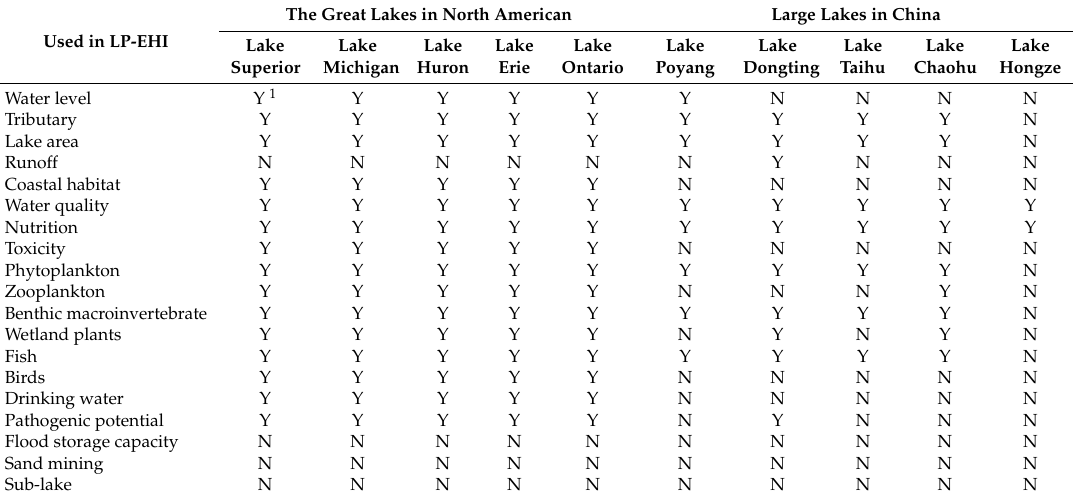
Table 3. Comparison of indicators for the Great Lakes in North American and five largest freshwater lakes in